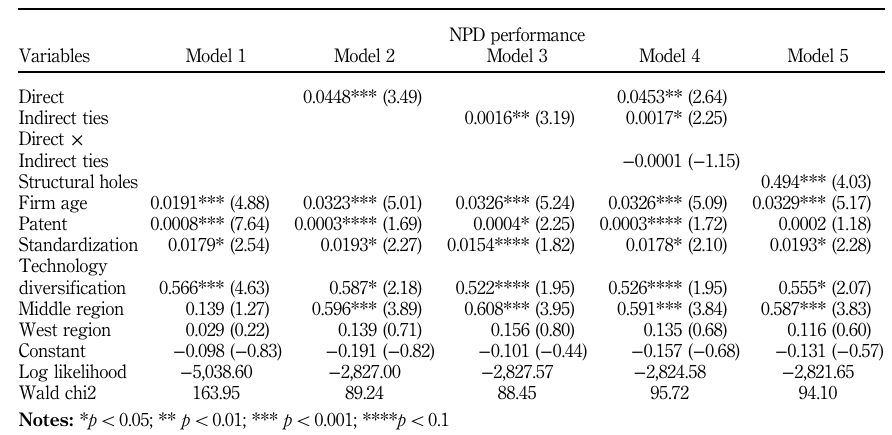
Figure 2. A technology-based collaboration network featured by a low degree of collaborative integration (2005 –